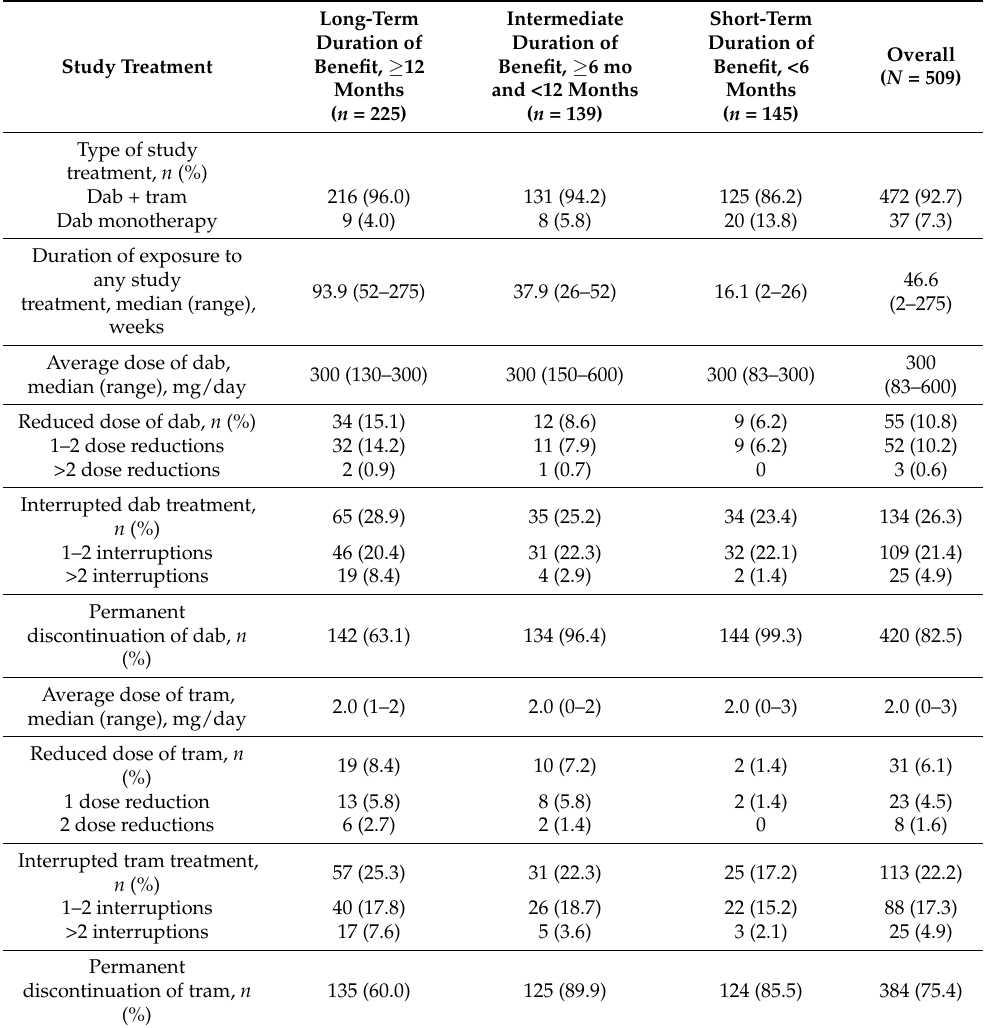
Table 4. Summary of study